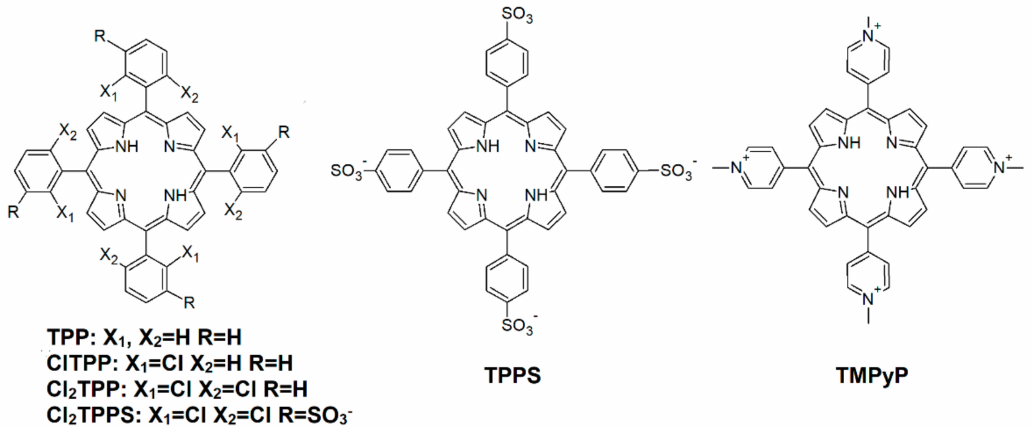
Figure 1. The chemical structures of the investigated